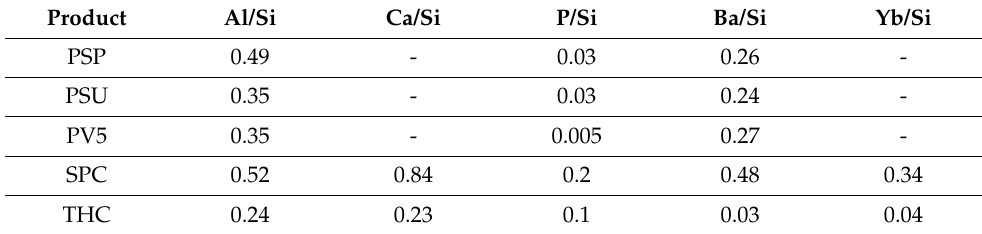
Table 6. Atomic ratios of the major elements in the products